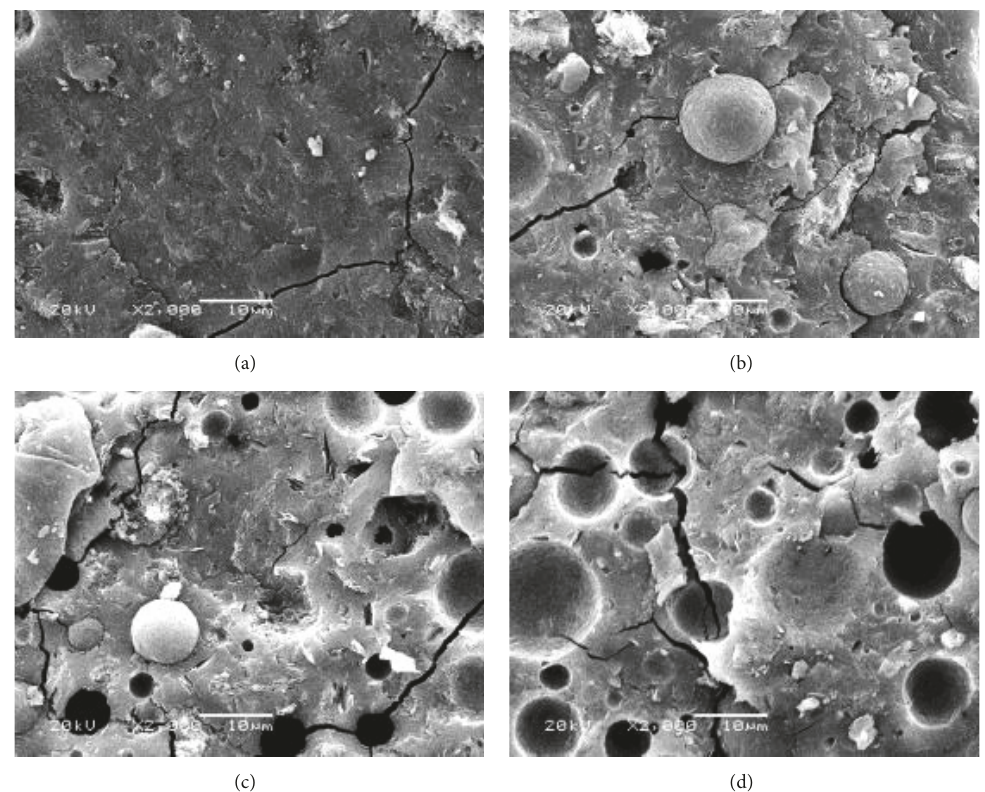
Figure 6: (a), (b), (c), and (d) represented the SEM images of EGP 0, EGP 10, EGP 20, and EGP 30 after curing for 28 days.